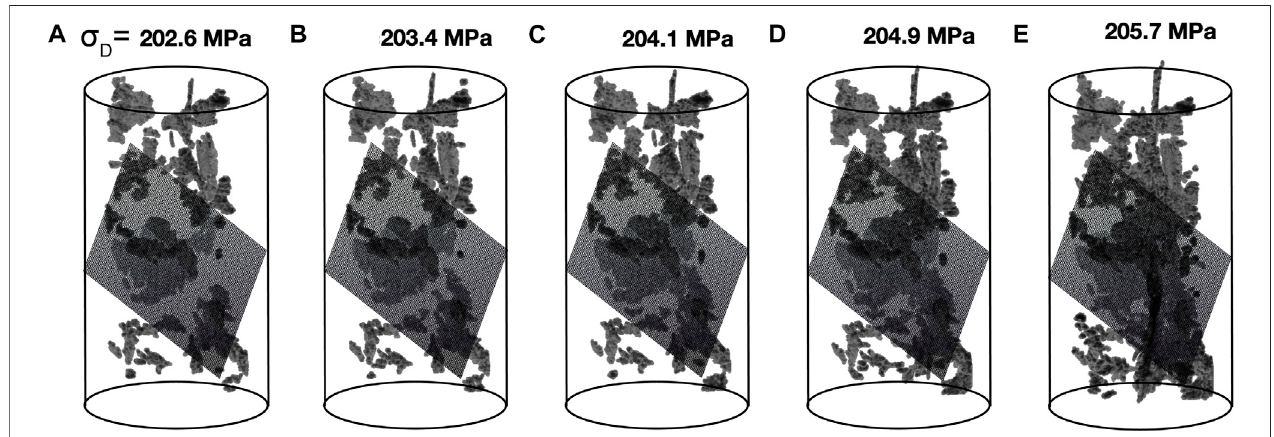
FIGURE 8 | Largest fractures, with volumes > 90th percentile, in the fi ve scans acquired before failure in the monzonite #5experiment, and best fi t plane of the fi nal fault geometry. The fi nal failure plane is built from the scan acquired immediately preceding failure. Numbers at the top of the cores show the differential stress when the scan was acquired.